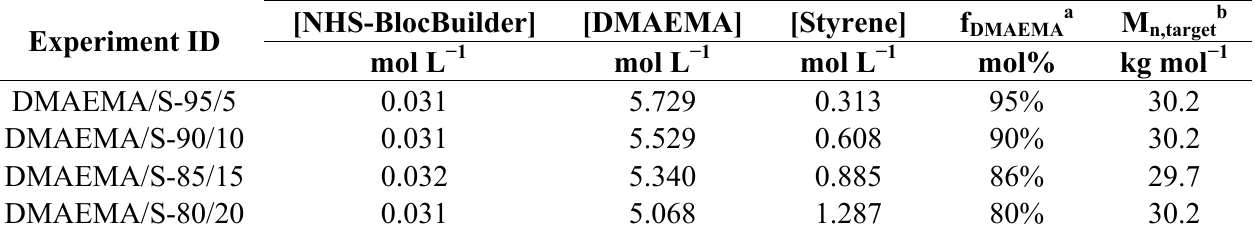
Table 1. Experimental conditions of the bulk copolymerizations of